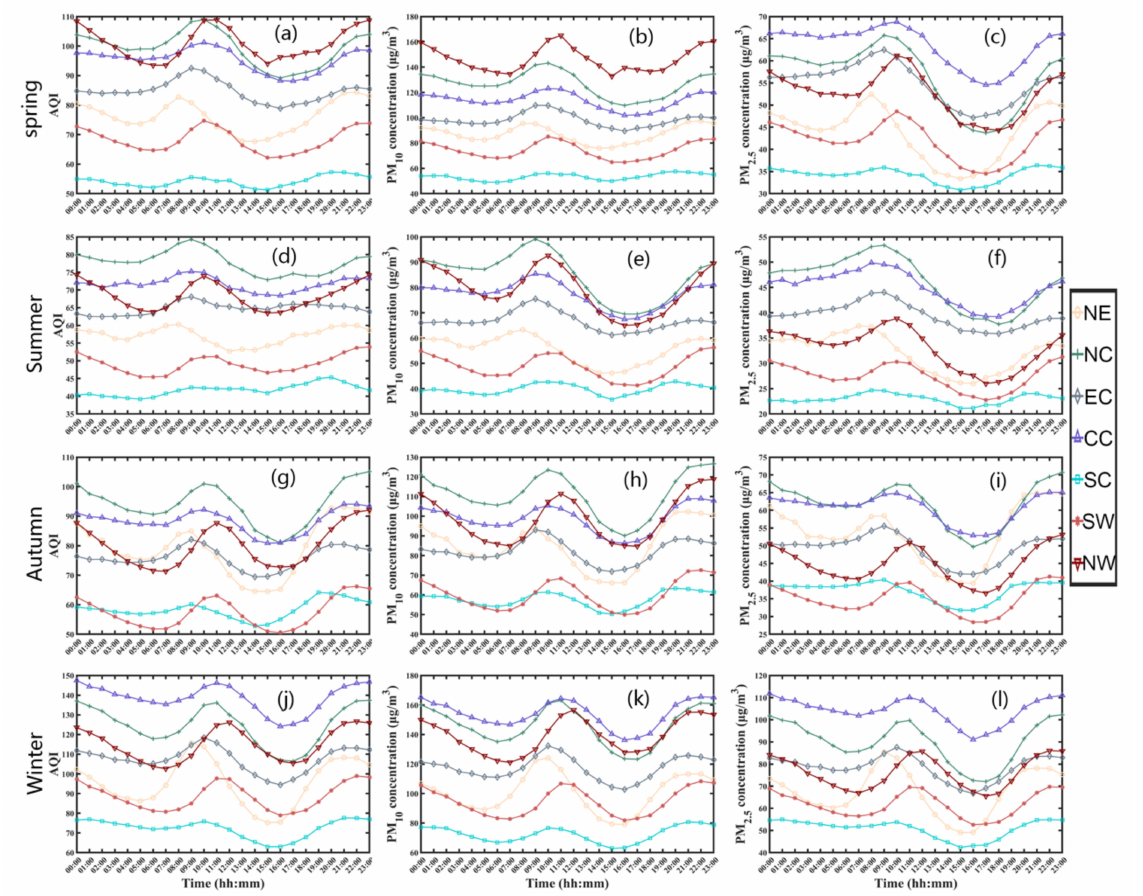
Figure 7. The diurnal variations of AQI, PM 10 concentration and PM 2.5 concentration in the seven regions in ( a – c ) spring, ( d – f ) summer, ( g – i ) autumn, and ( j – l )